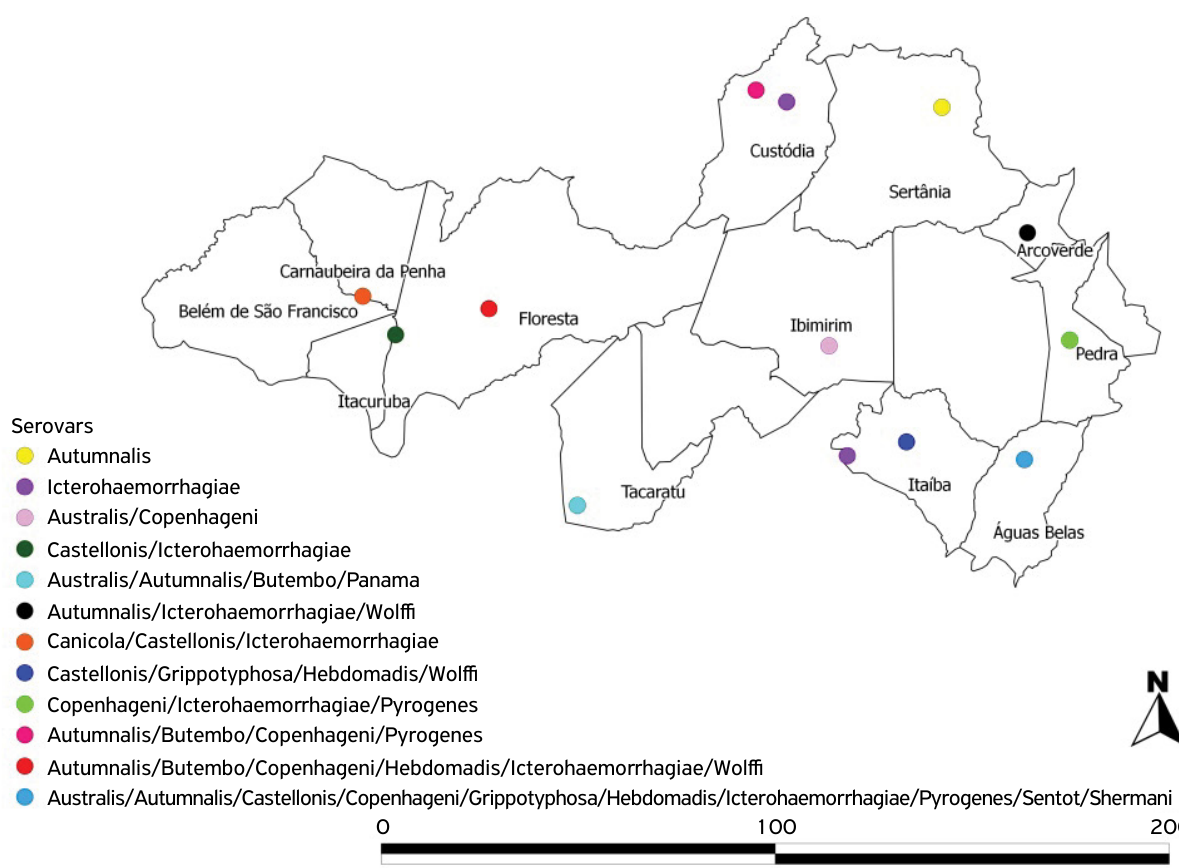
Figure 2. Distribution of Leptospira spp. in properties with seropositive sheep in Pernambuco state,